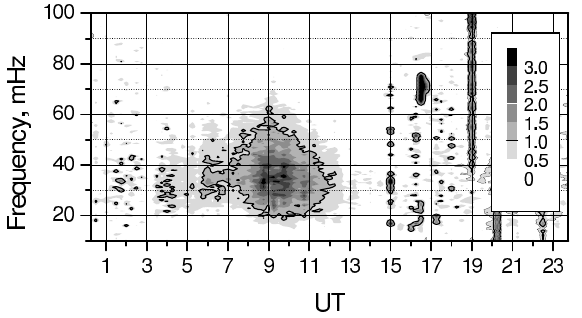
Fig. 5. Diurnal spectrogram of the signal -to- noise power ratio R at Davis over 1996, calculated for the spectrogram in the top panel of Fig. 2. A solid line contour corresponds to R =